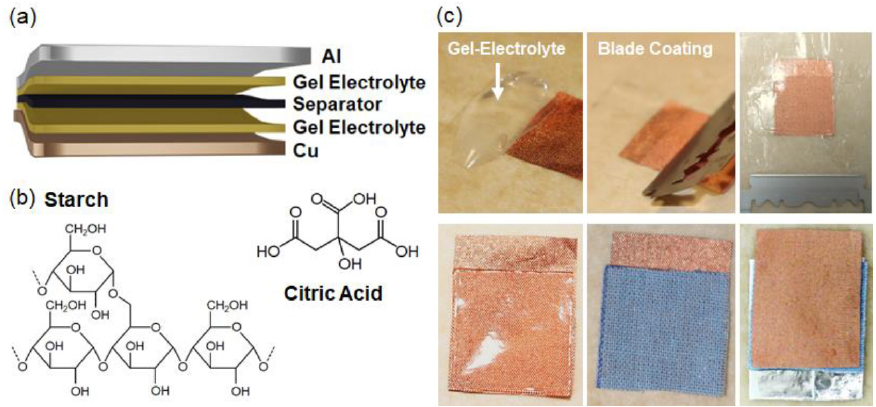
Figure 1. ( a ) Schematic architecture of textile-based battery, ( b ) chemical structure of both materials for the gel electrolyte, and ( c ) the fabrication process of the textile-based